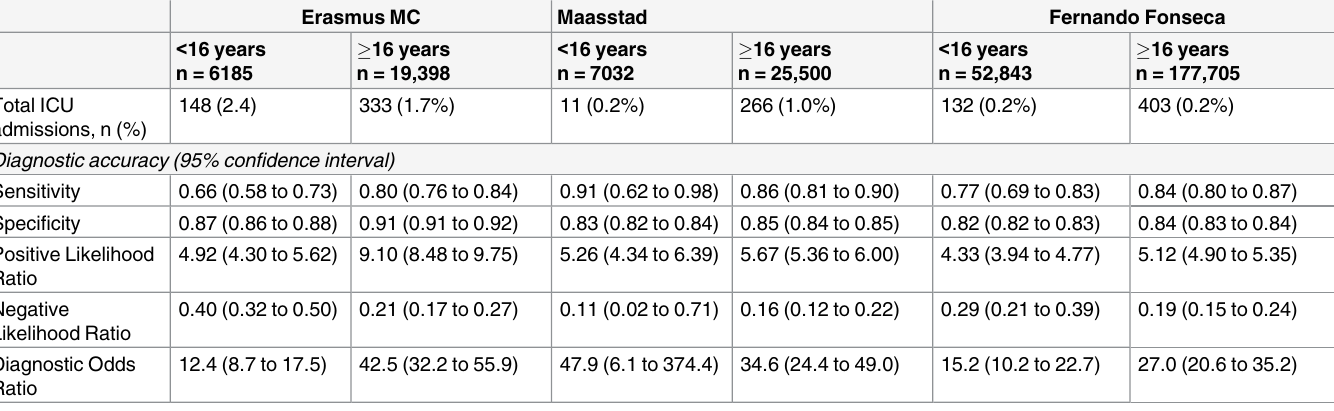
Table 3. Diagnostic performance of the MTS for the identification of patients who died at the emergencydepartment or required ICU admission. Erasmus MC Maasstad Fernando